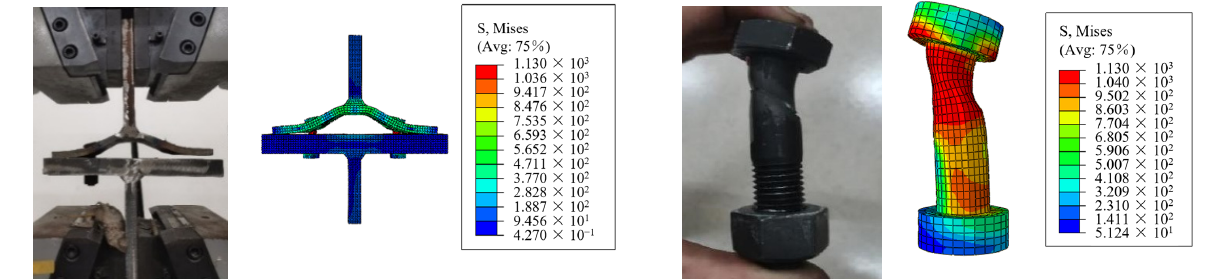
Figure 10. Test and finite element model failure mode.